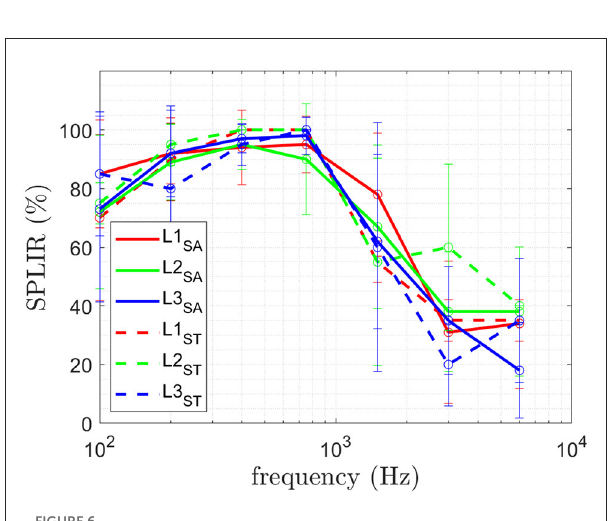
FIGURE6 The mean and standard deviation of the SPLIR for each site L1, L2, and L3 is shown. The results of the ten able-bodied subjects (SA) is plotted in solid lines and for subjects with trans-radial amputation